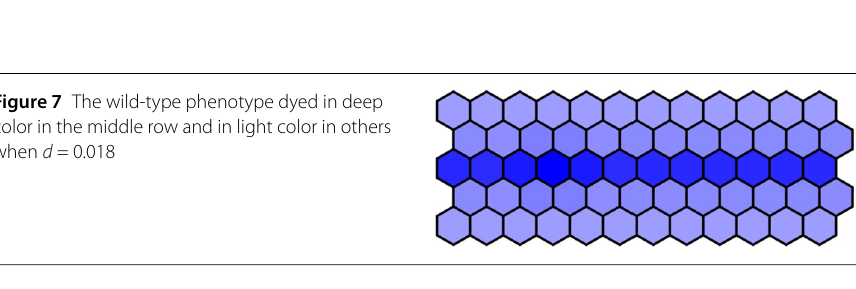
Figure 6 The sensitivity test of λ from 600 to 1400. ( A ) The dynamical trend of Delta and active Notch in cell 1. ( B ) The dynamical trend of Notch in cell 1. ( C ) The dynamical trend of Delta and active Notch in cell 2. ( D ) The dynamical trend of Notch in cell 2